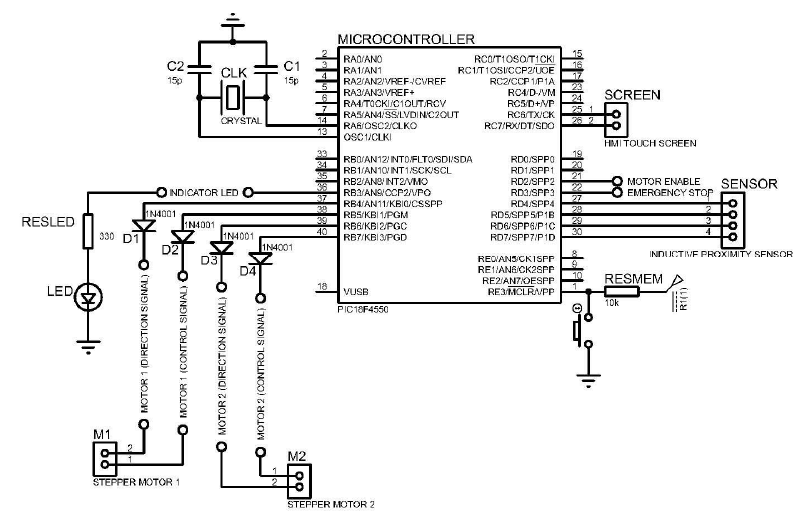
Figure 10. Electronic circuit diagram.